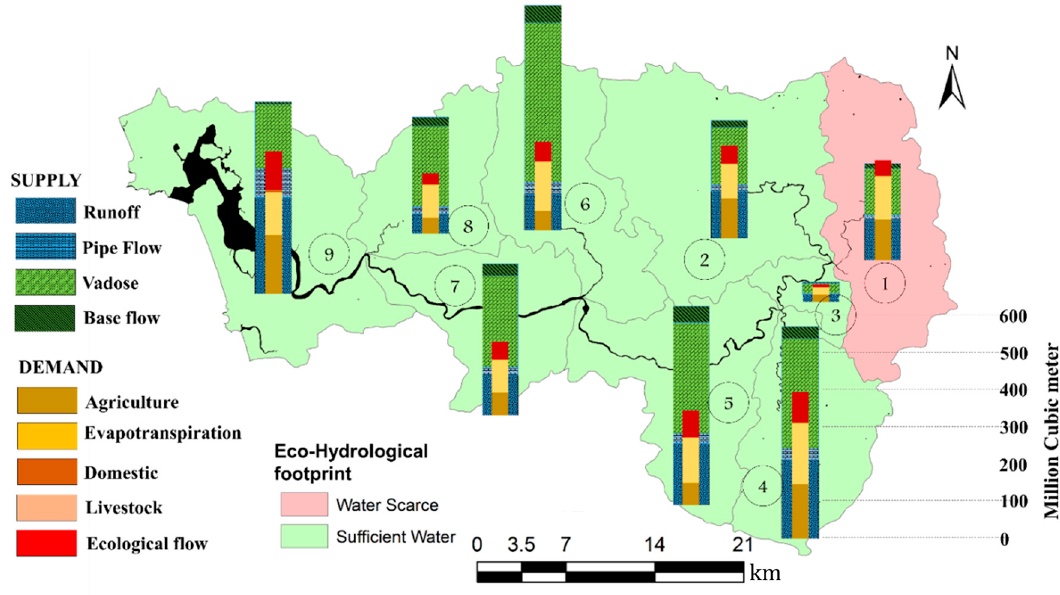
Figure 5. Eco-hydrological footprint of Aghanashini River.